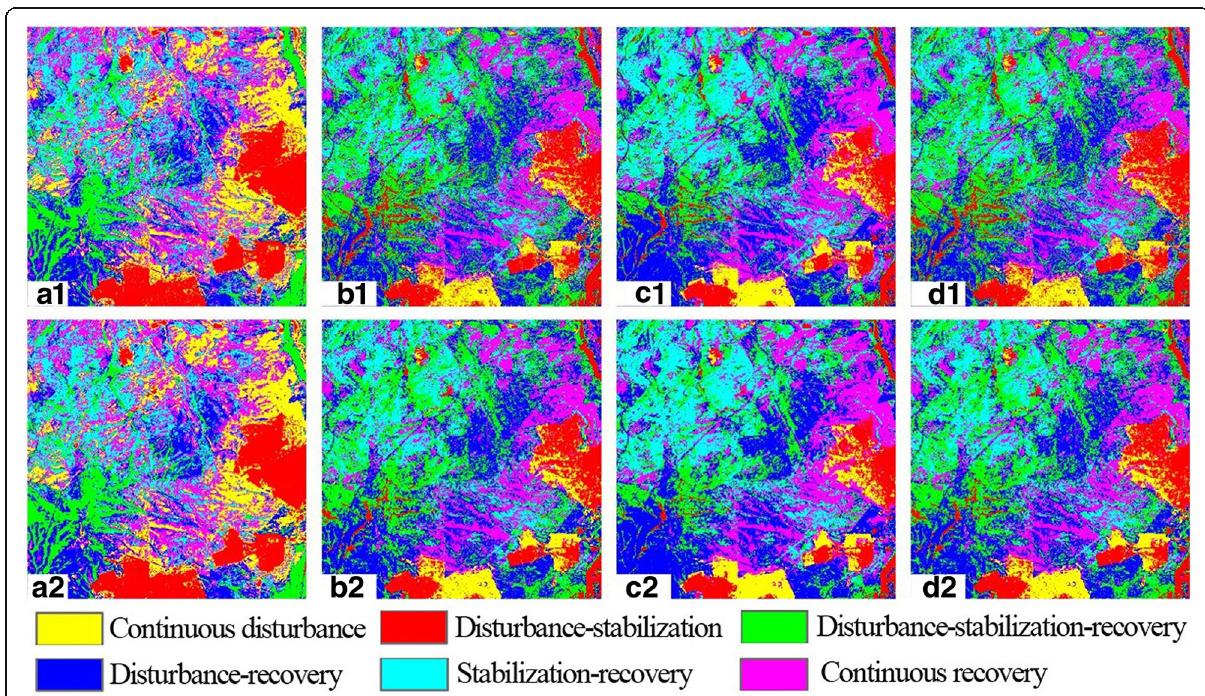
Fig. 4 Comparison of MRF spatial structure before and after Optimization. a Semi-FCM. b Semi-DTW-FCM. c Semi-Gaussian-FCM. d Semi-GDTW- FCM. 1 Before the MRF optimization; 2 After the MRF optimization